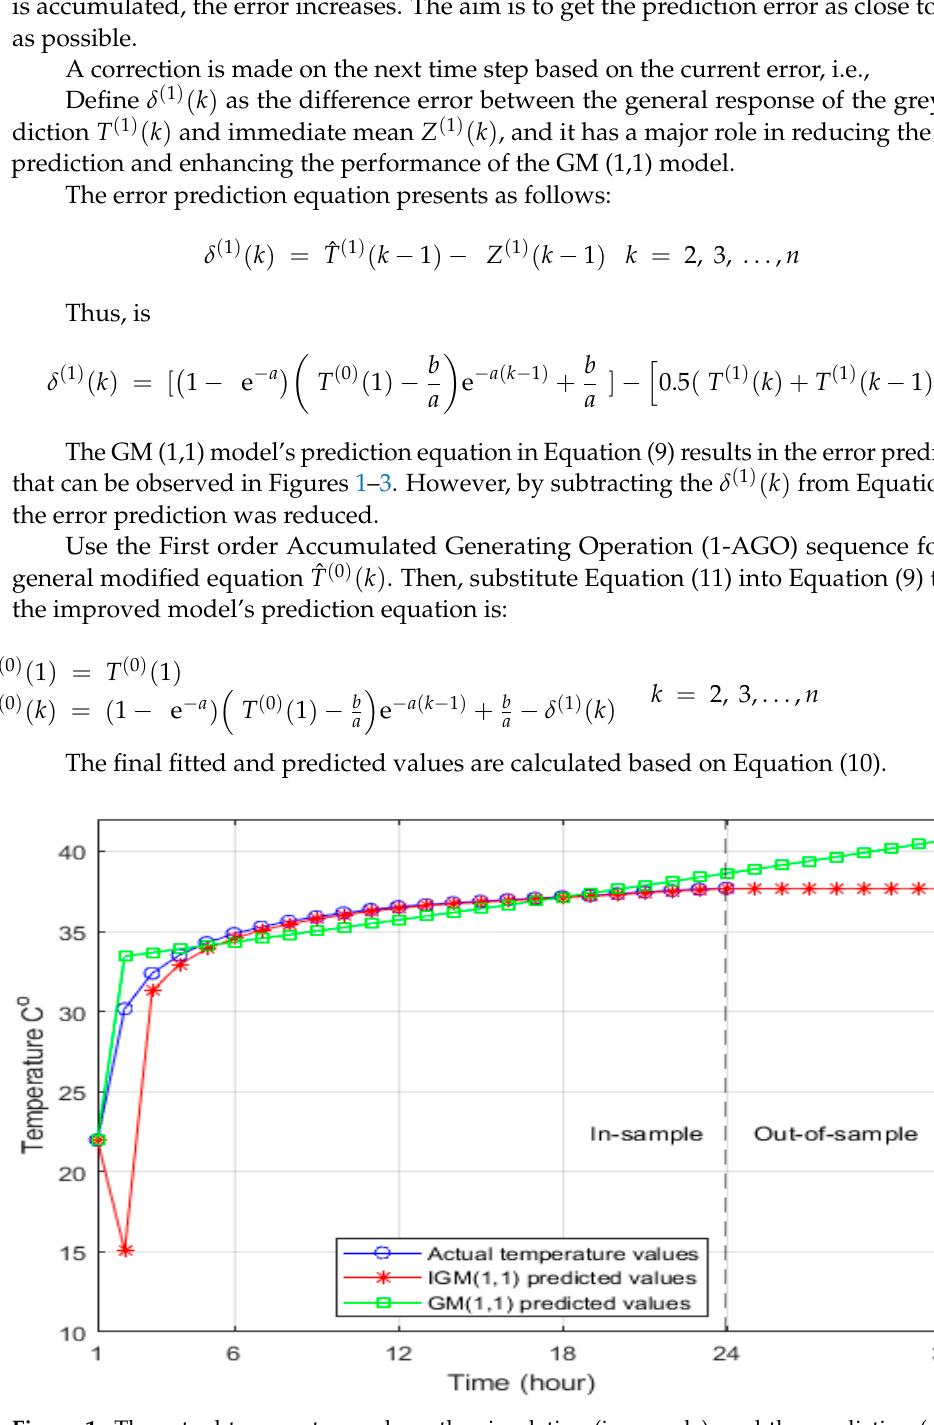
Figure 1. The actual temperature values, the simulation (in-sample), and the prediction (out-of-sample) results of Oklahoma University’s GHPS output temperature for the next eight hours using both the IGM (1,1) and GM (1,1) models.